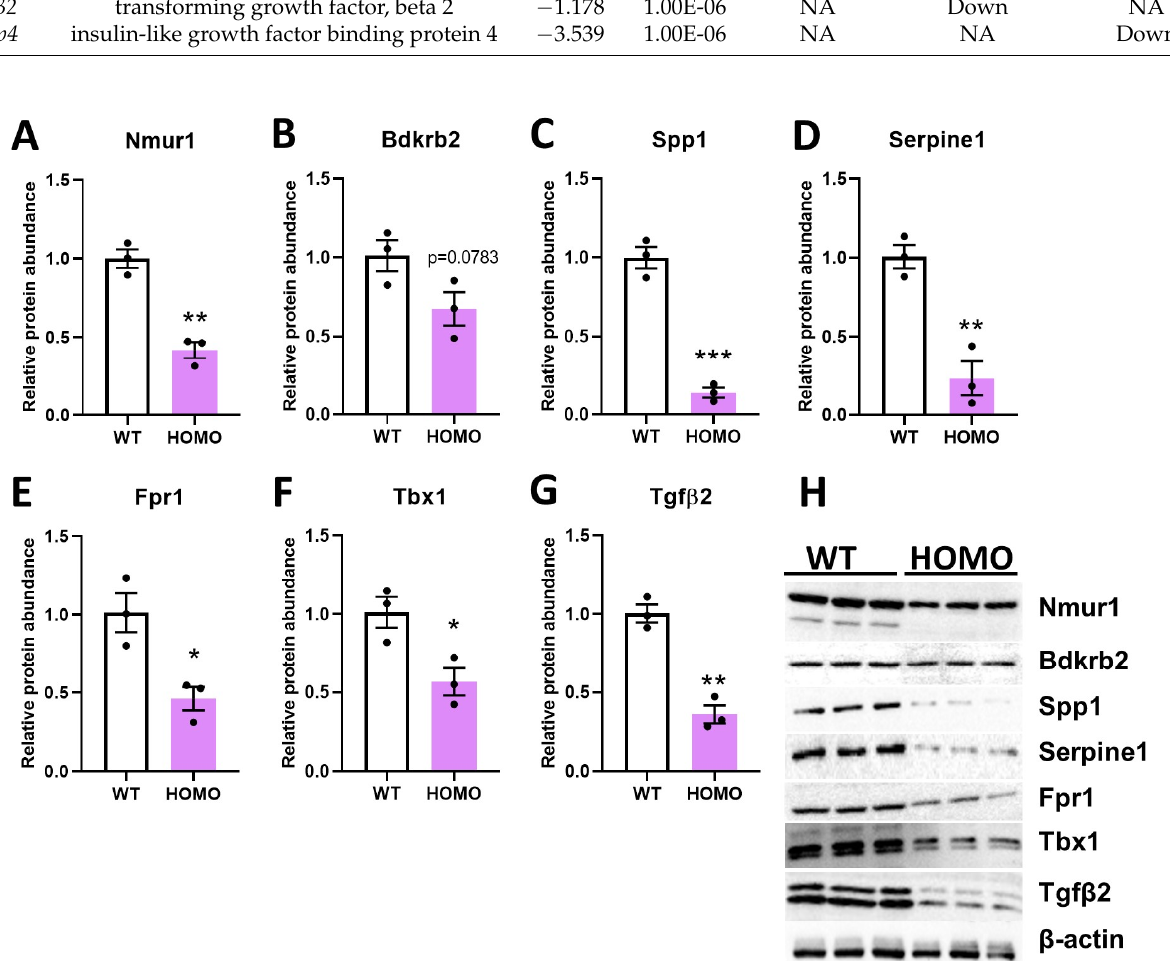
Figure 4. Effect of hIGFBP5 on Intracellular Protein Abundance. Cell lysates were analyzed by immunoblotting for selected proteins. Quantification of immunoblots (n = 3) for the protein abundance of ( A ) Nmur1, ( B ) Bdkrb2, ( C ) Spp1, ( D ) Serpine1, ( E ) Fpr1, ( F ) Tbx1 and ( G ) Tgf β 2. The housekeeping protein used to normalize the data was β -actin. * p < 0.05. ** p < 0.01. *** p < 0.001. WT: wild type female mice, HOMO: hIGFBP5 homozygous female mice. ( H ) Representative immunoblots for each protein shown in panels A-H and β -actin as a loading control.